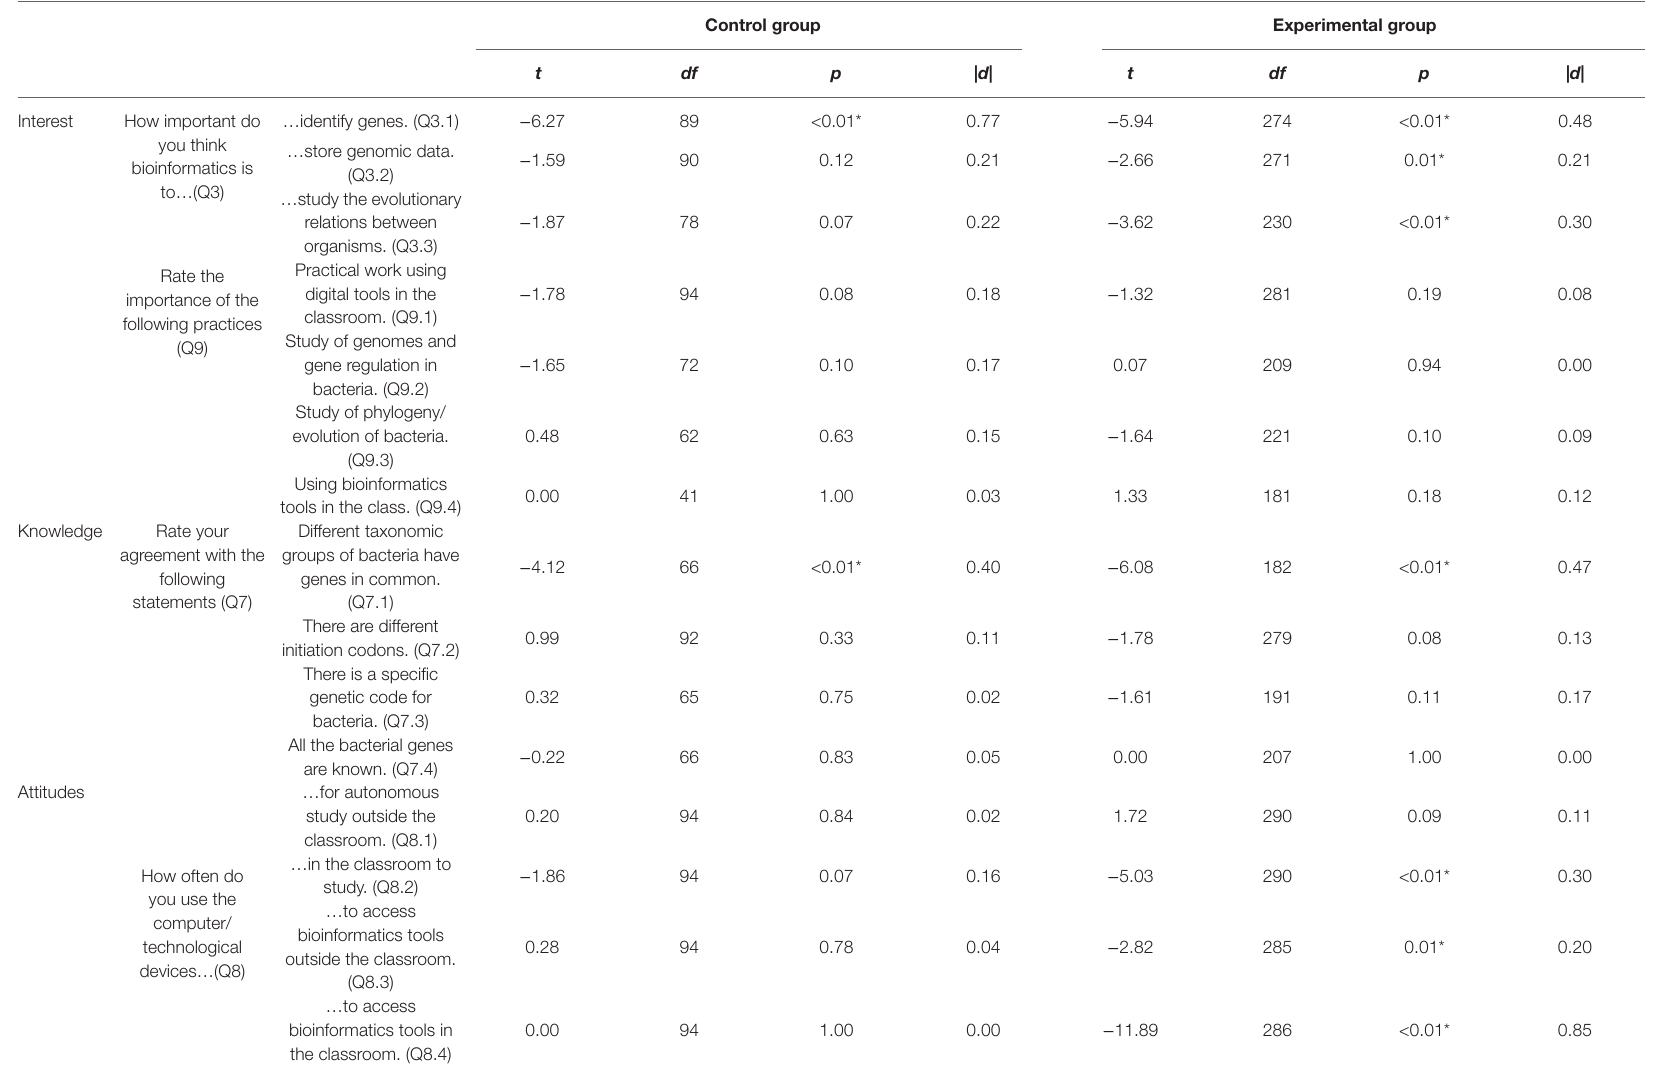
TABLE 1 | Pre- and post-test comparison of students’ knowledge, interest, and attitudes toward bioinformatics. Control group Experimental